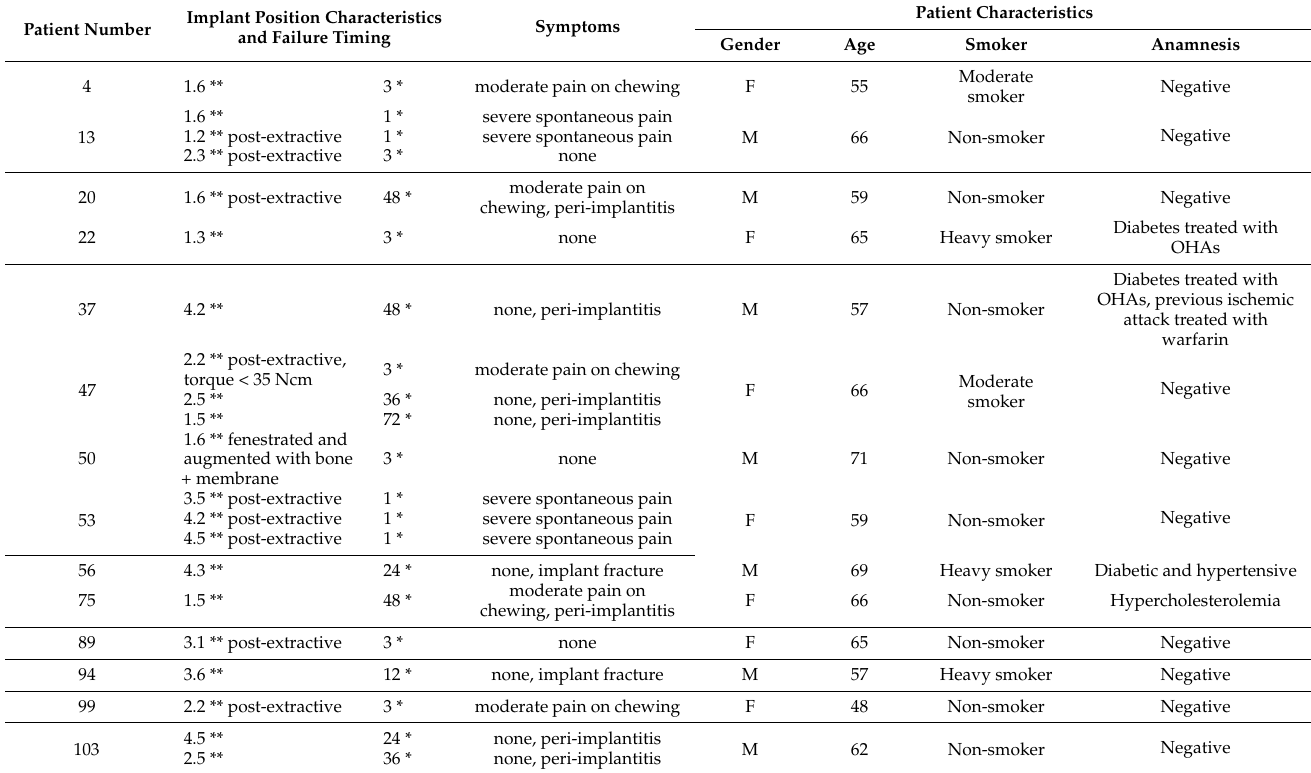
Table 3. Description of the implant failures that occurred up to 7-year